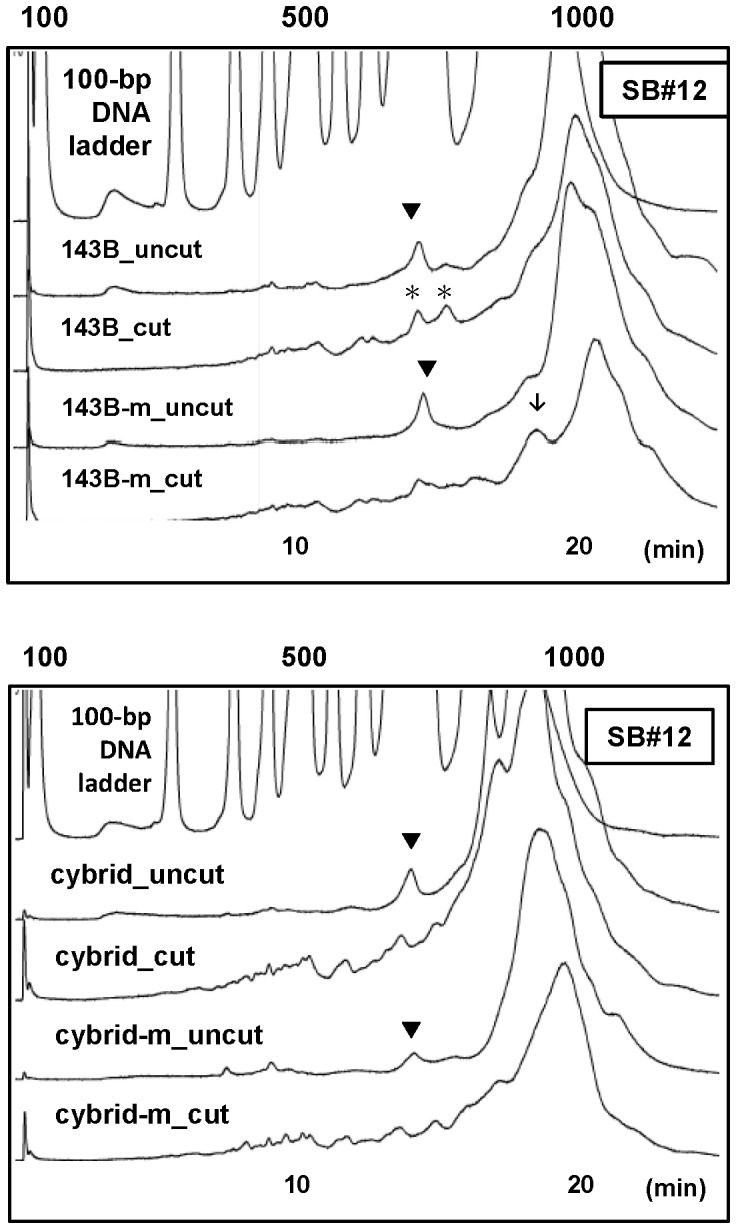
Results from SN/WAVE-HS analysis of the SB#12 amplicon by using total DNA and mtDNA from cells.DNA samples from isolated mitochondria (m) and whole cells of 143B cells and the cybrid were used. The upper and lower panels display the results for 143B cells and the cybrid cells, respectively. The results for the DNA samples without (uncut) and with (cut) SN digestion were also compared. ▾ indicates the peaks that appeared in the chromatograms of uncut DNA but were absent in the chromatograms of the corresponding cut DNA for all DNA samples. Two obvious peaks (indicated by *) showed up after SN digestion for the total DNA of 143B cells, but could not be apparently visualized for the mtDNA of 143B cells (upper panel).↓ indicates the peak close to 1000 bp in the cut DNA of the mtDNA, but not in the cut DNA of the total DNA from 143B cells (upper panel). These two differences in the patterns of peaks between total DNA and mtDNA found in 143B cells were absent in the cybrid cells (lower panel).